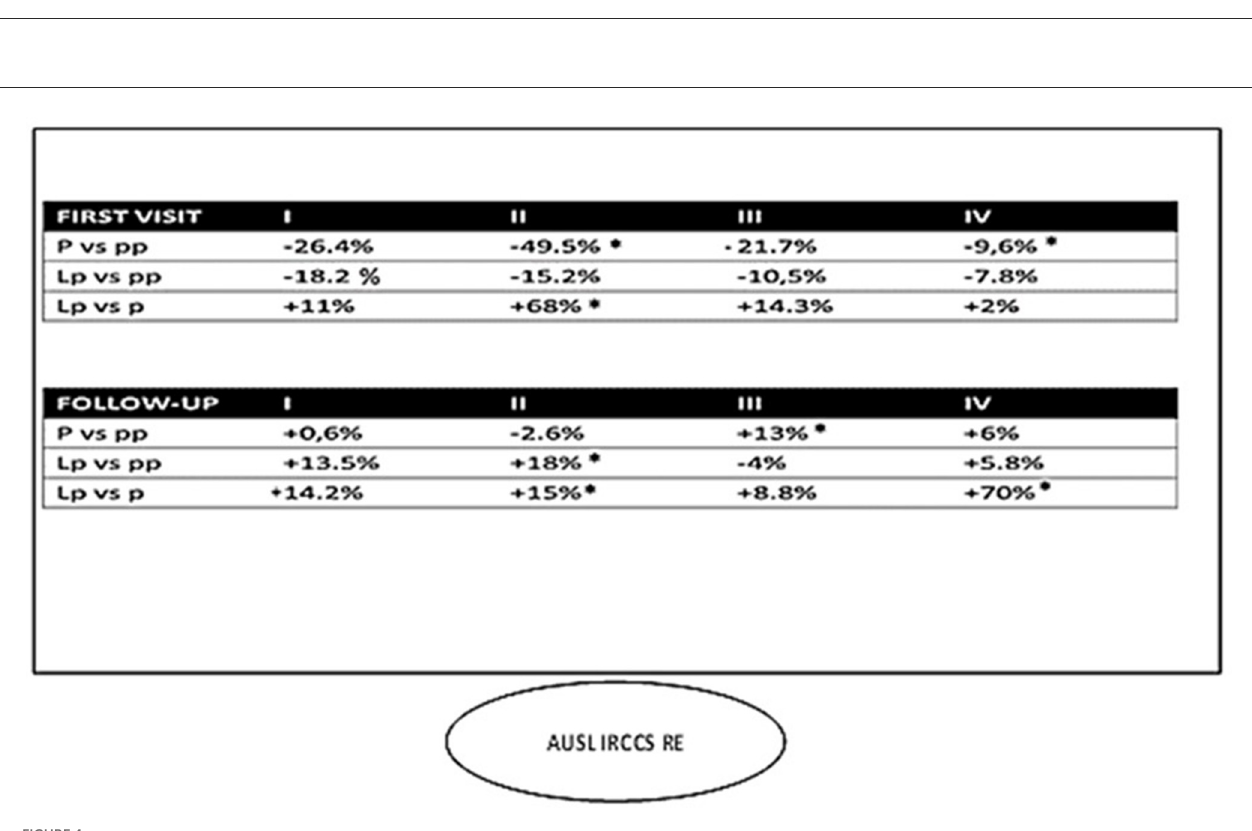
FIGURE4 Visit volume at the AUSL IRCCS of Reggio Emilia by quarter. * p <